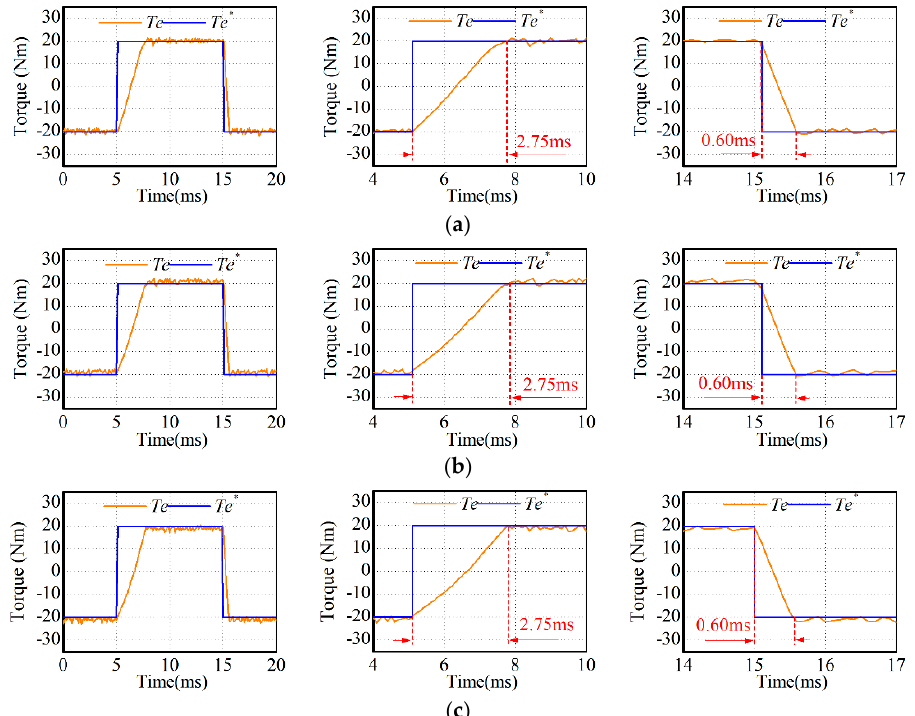
Figure 10. Torque response performances for ( a ) accurate measurement, ( b ) under-voltage measurement, and ( c ) over-voltage measurement.